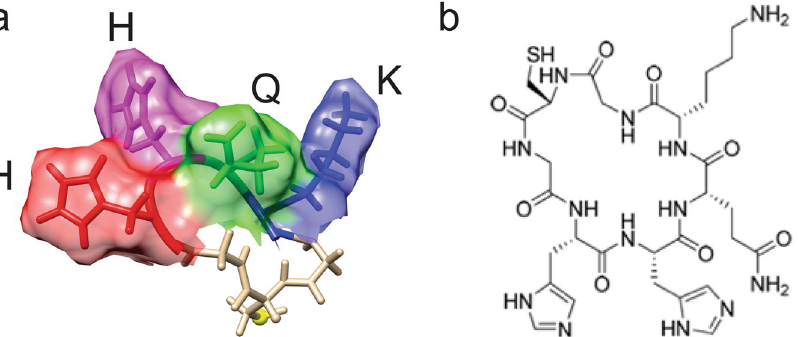
Figure 1. A β residues 13–16, HHQK, held in a constrained turn represent a predicted A β O-specific epitope. ( a ) Representative molecular dynamics simulated conformation of the cyclic HHQK epitope, with the side chains oriented into solvent. Yellow dot is sulfhydryl on terminal cysteine, used for conjugation to carrier proteins. ( b ) Skeletal structural formula of